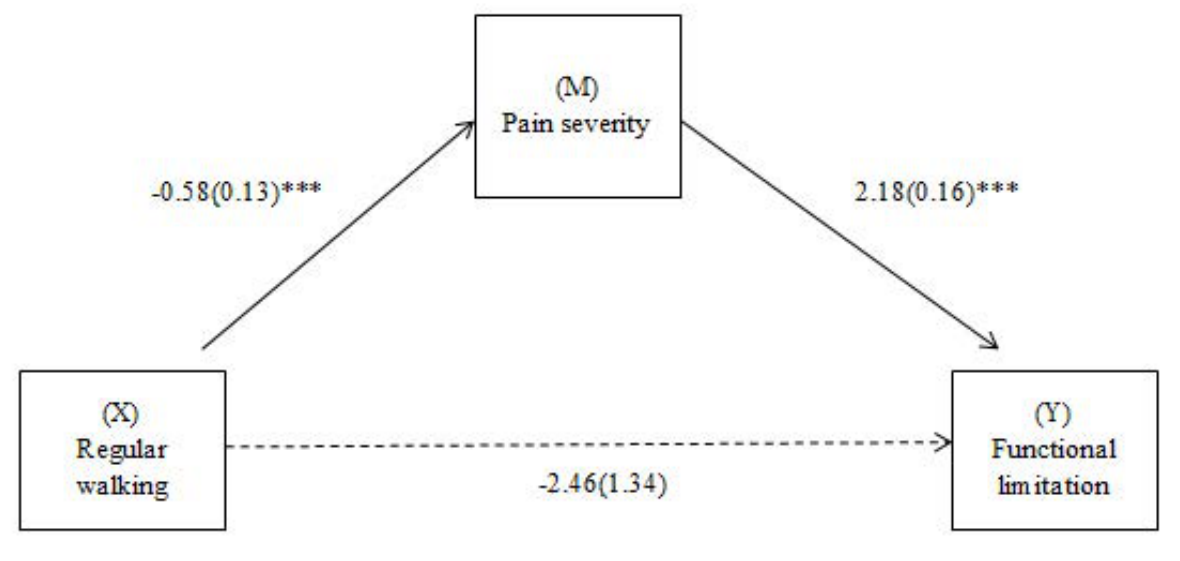
Figure 2. Path diagram illustrating direct and mediating effects that relate regular walking to functional limitation (with pain severity as mediator).